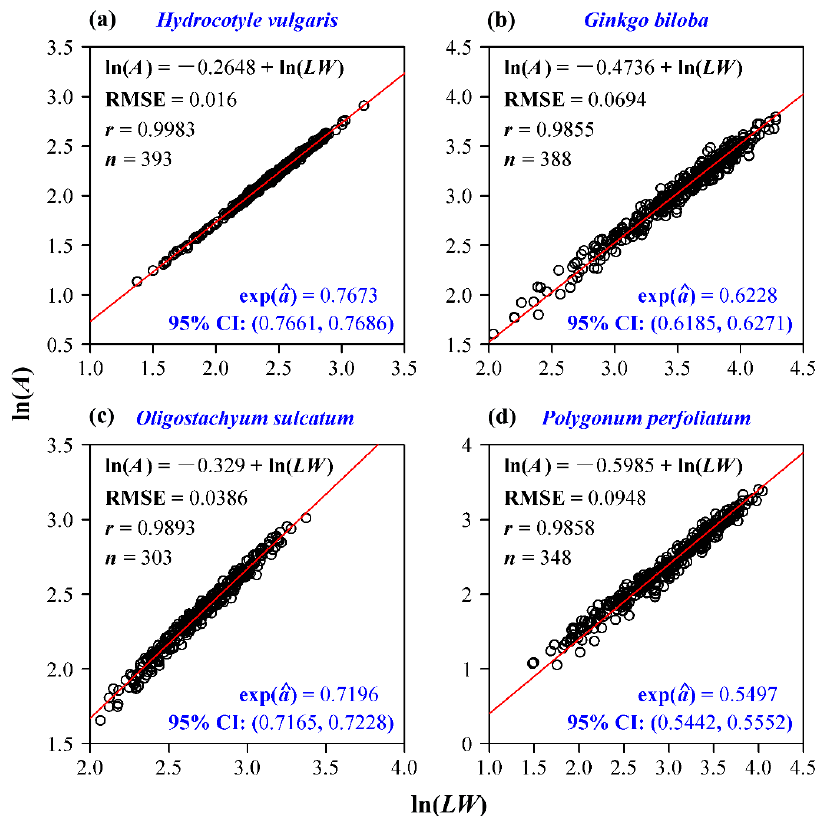
Figure 2. Linear regression of the Montgomery equation for four species of plants. ( a ) H. vulgaris ; ( b ) G. biloba ; ( c ) O. sulcatum ; ( d ) P. perfoliatum . In each panel, A denotes leaf area; L represents leaf length; W represents leaf width; RMSE represents the root-mean-square error; r represents the correlation coefficient; n represents the number of leaves sampled; exp(ˆ a ) represents the estimate of the Montgomery parameter; 95% CI denotes the 95% confidence interval of the estimate of the Montgomery parameter. Open circles represent the observations, and the red straight line represents the fitted regression line.